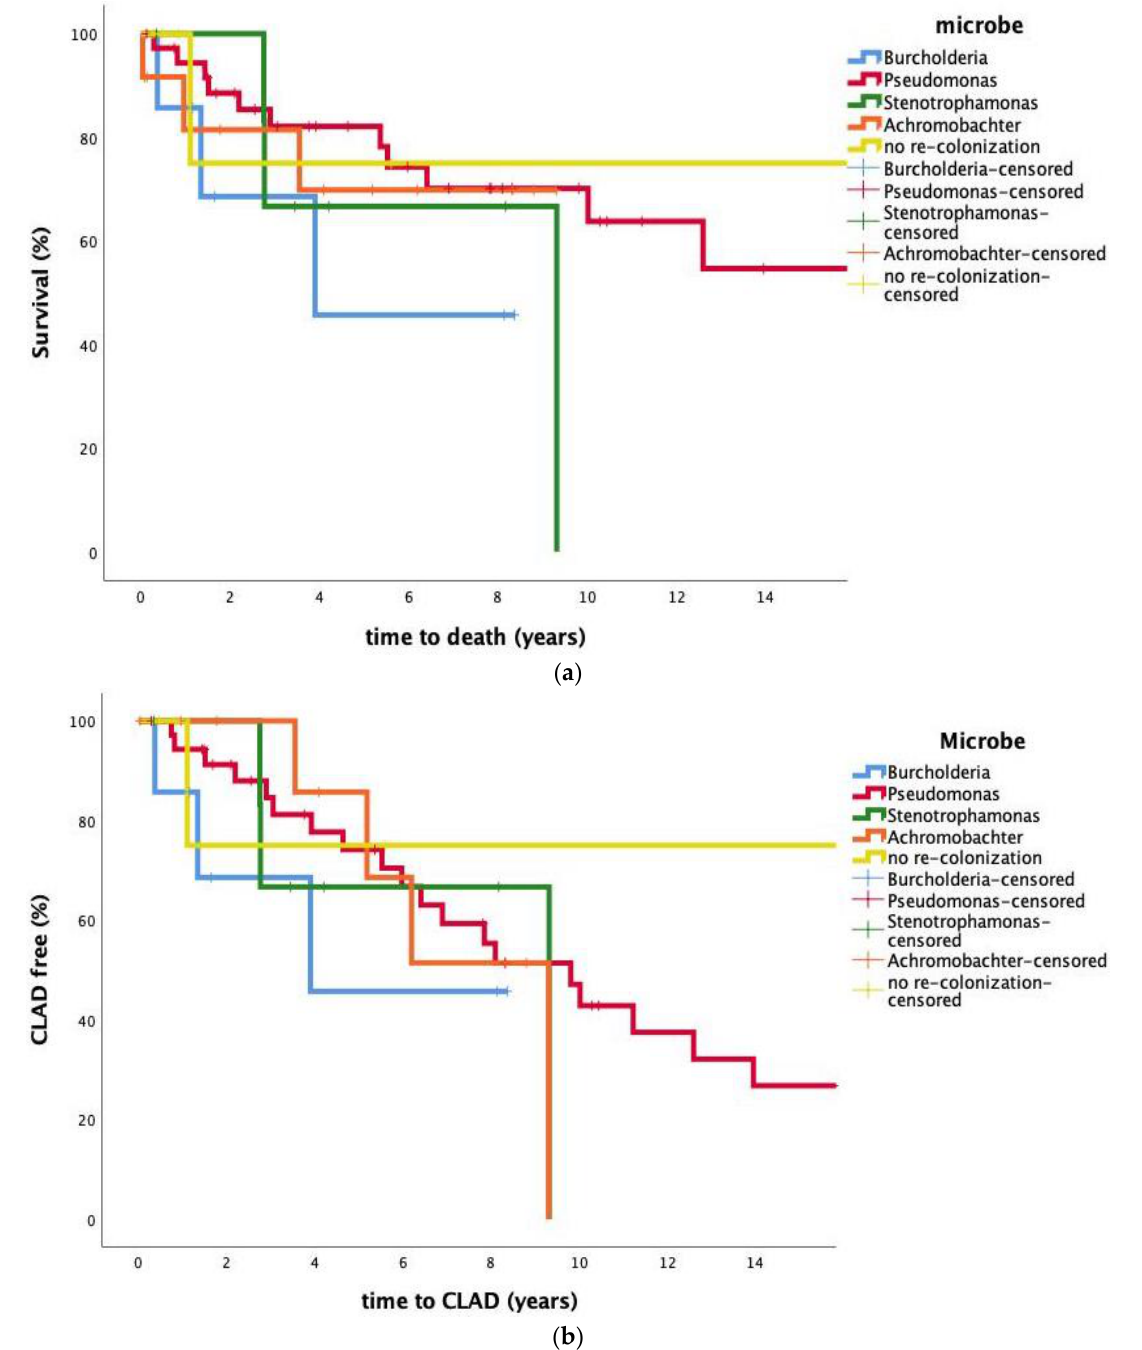
Figure 4. ( a , b ) demonstrate the time CLAD and death after transplantation stratified for different bacteria.